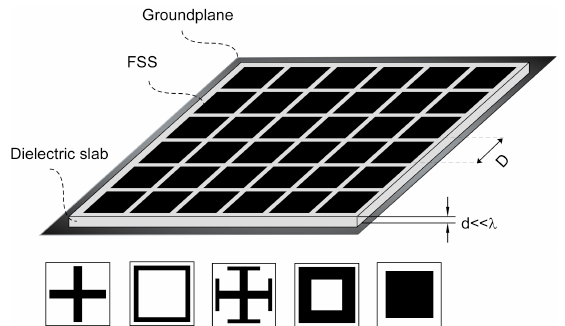
Figure 1- 3D sketch of the HIS absorber with some of the most common unit cell pattern. The periodic pattern can be metallic or